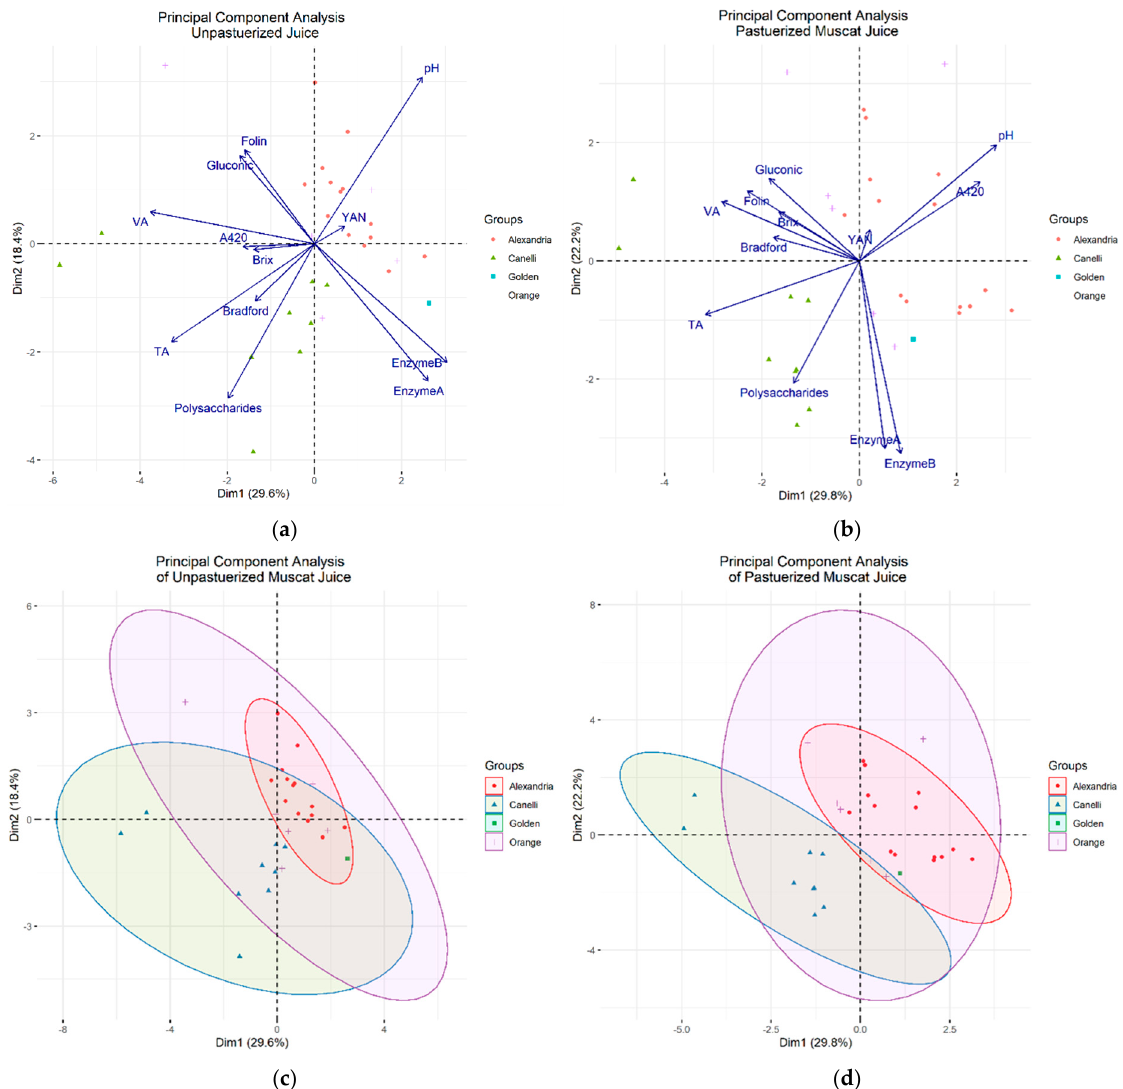
Figure 5. Principal component analyses of all Muscat juices separated into unpasteurized ( a , c ) and pasteurized ( b , d ) samples.